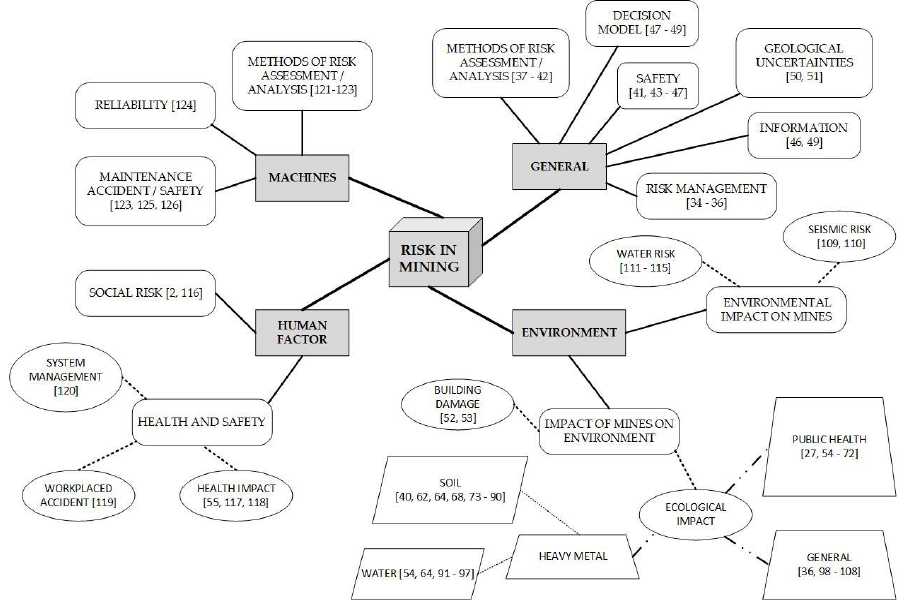
Figure 8. The main problems analyzed in the selected papers.